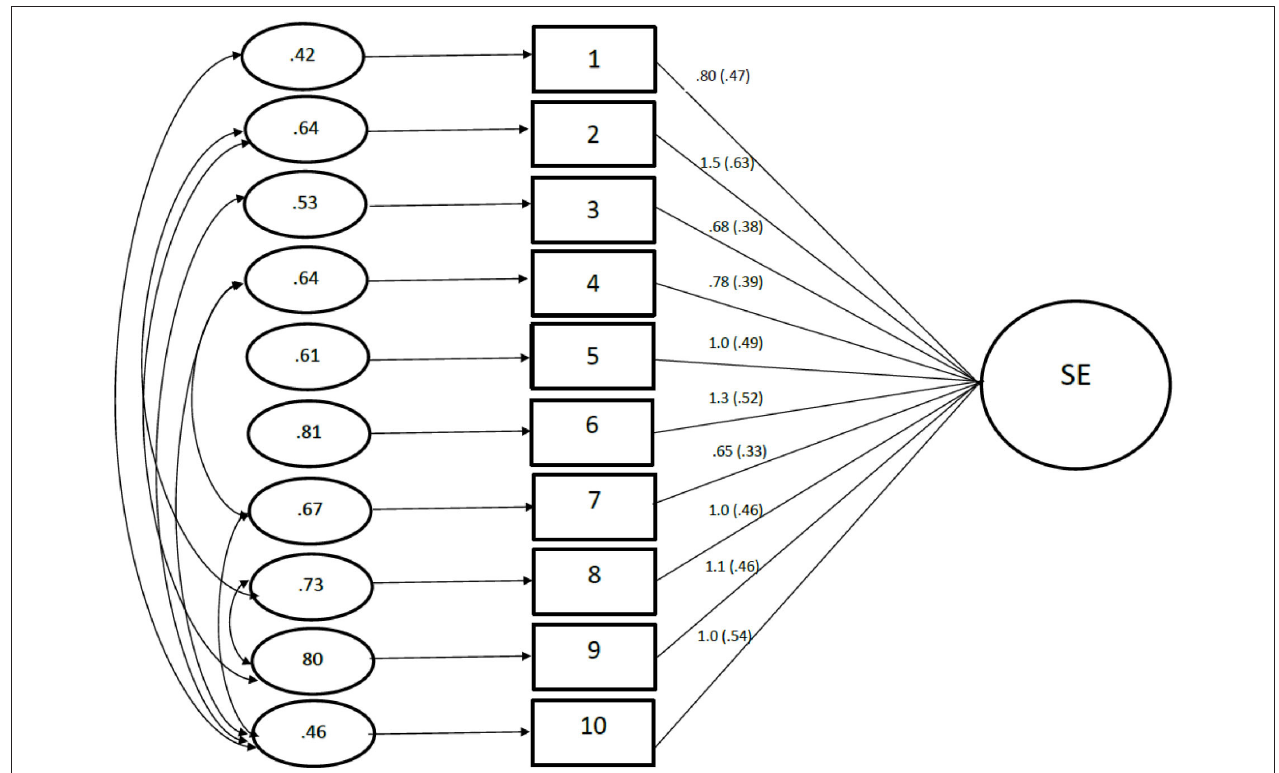
FIGURE 1 | Global SE model for the Child Rosenberg Self-esteem Scale. Item numbers in the figure represent the items in the Child Rosenberg Self-esteem Scale. The large circle is the global self-esteem score, with the rectangles representing the measured variables, and the small circles with numbers are variances. The factor loadings are standardized in parenthesizes and unstandardized outside.